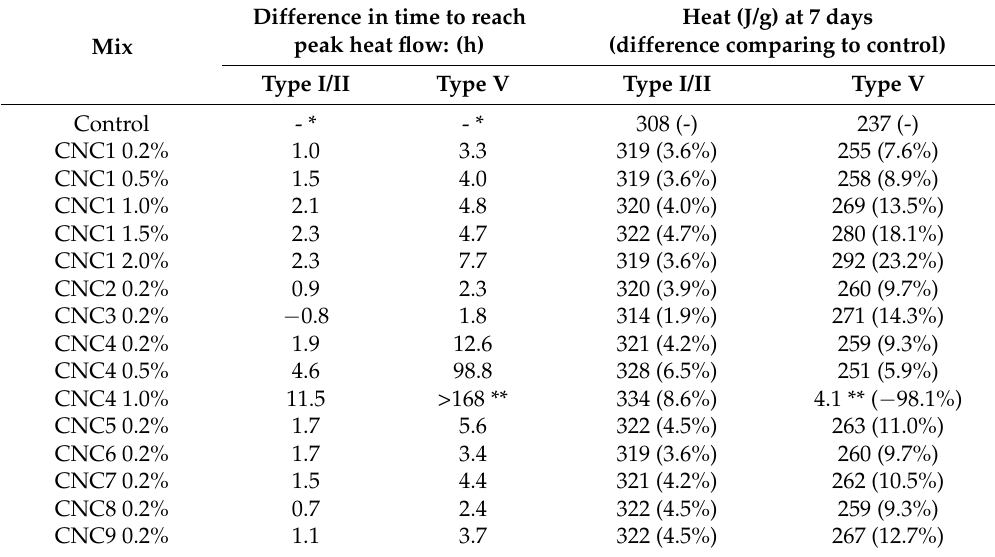
Table 3. Effect of CNCs on cement